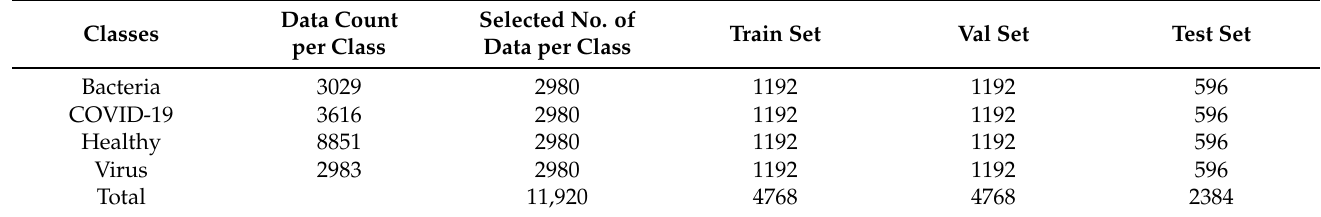
Table 1. Distribution of CXR image dataset and their descriptions, showing different categories of pneumonia, healthy and COVID-19 image scans, as well as the number of selected images per category.